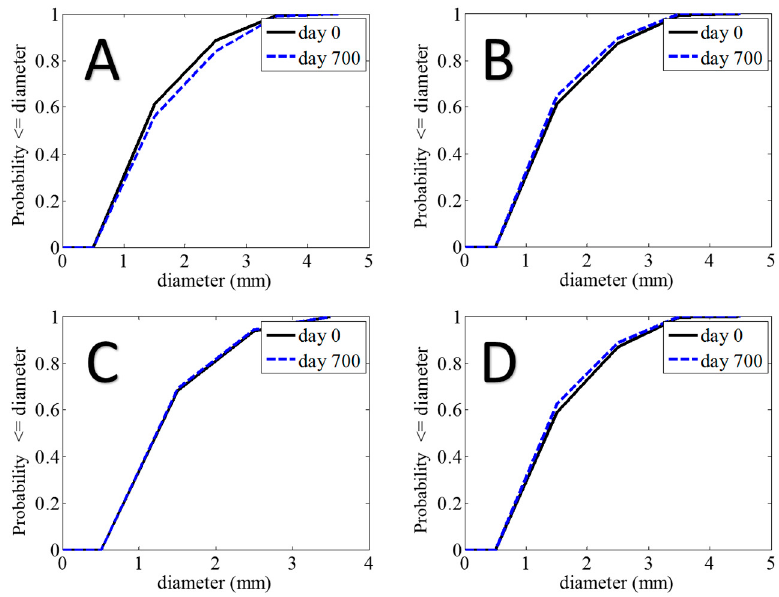
Figure 5. Sample patient CDFs demonstrating the temporal changes from day 0 to 700. The graphs indicate the probability that blood vessels may be of a certain diameter or less. ( A – D ) represents 4 different patients from our dateset. Table 3. BP measurements of patients A, B, C, and D.